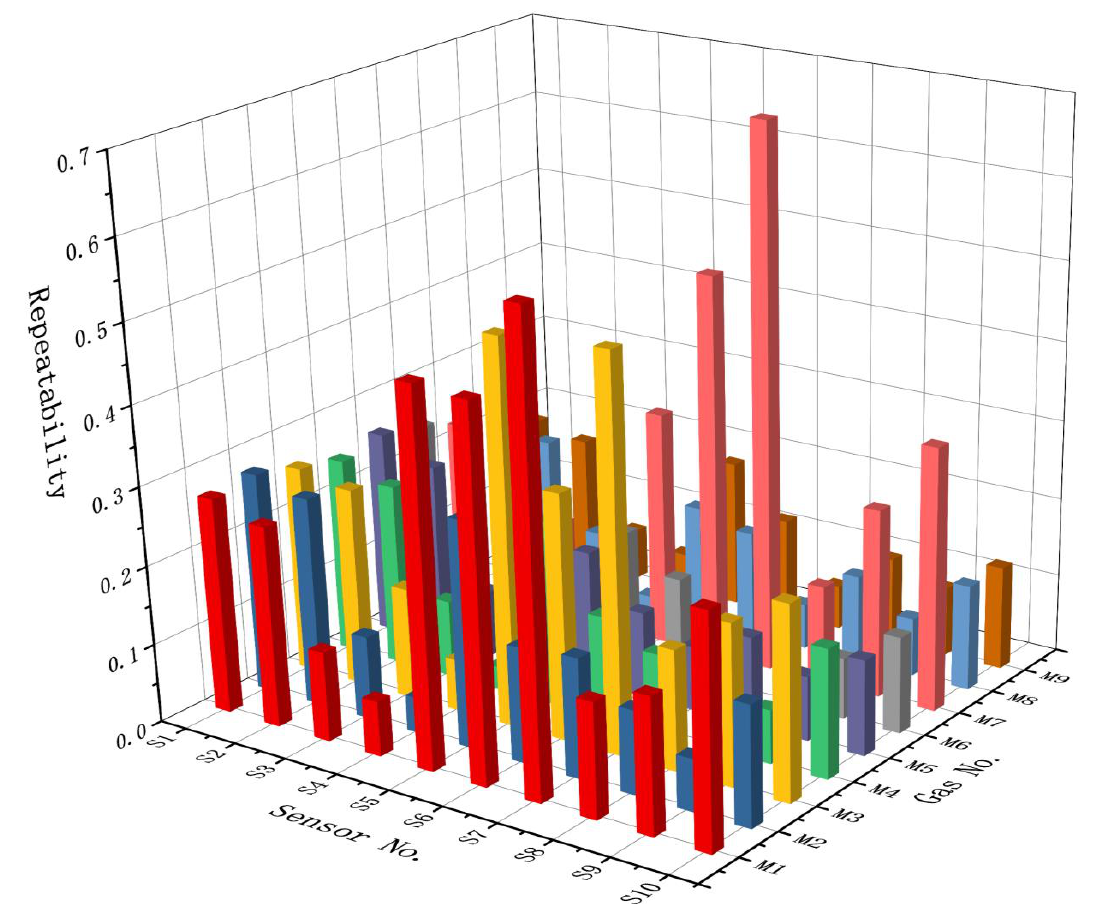
Figure 8. Repeatability results of all sensors in the initial sensor array.